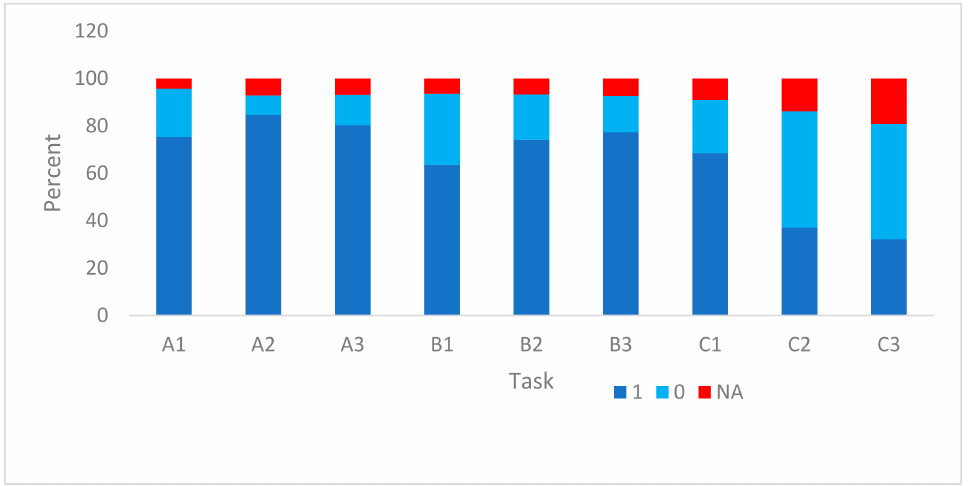
Figure 6. Graph of the success at solving tasks A1 to